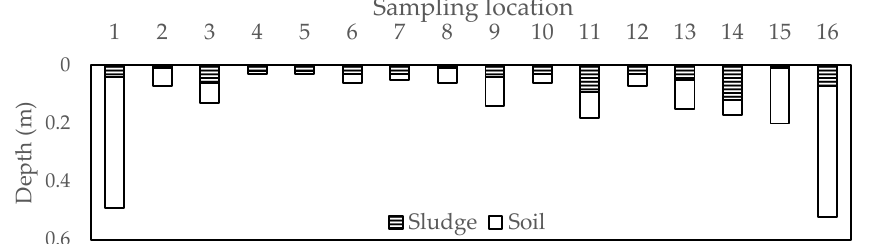
Figure 1. Graph showing the thickness of oily sludge and the underlying contaminated soil at the 16 sampling locations within the investigated oilfield waste pit.